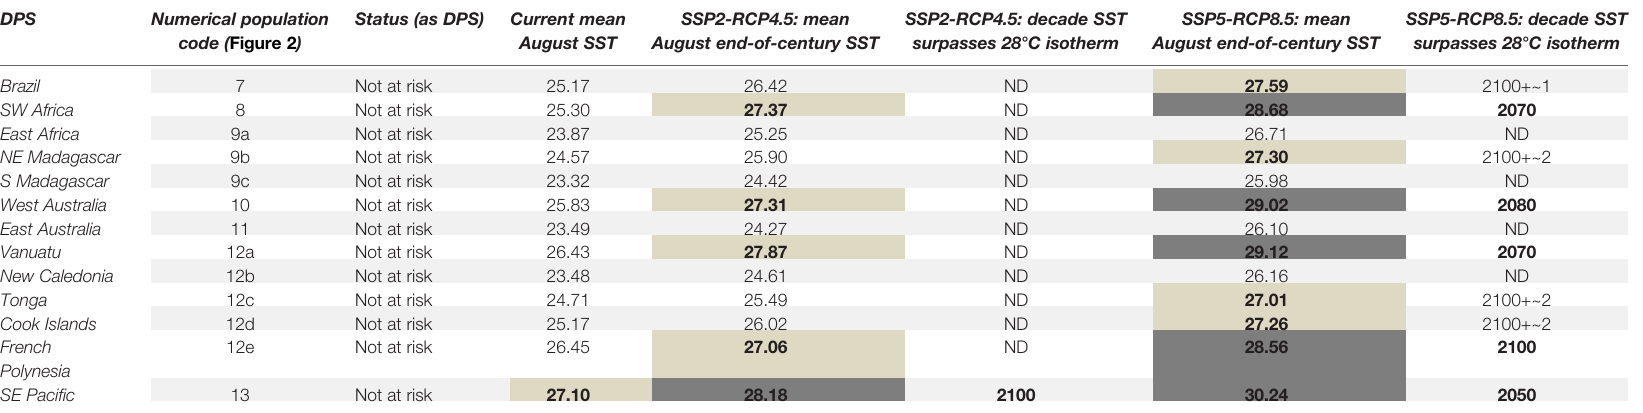
TABLE 2 | Southern Hemisphere humpback whale DPS names, numerical population codes (corresponding to Figure 2 ) and conservation status. DPS Numerical population code ( Figure 2 )